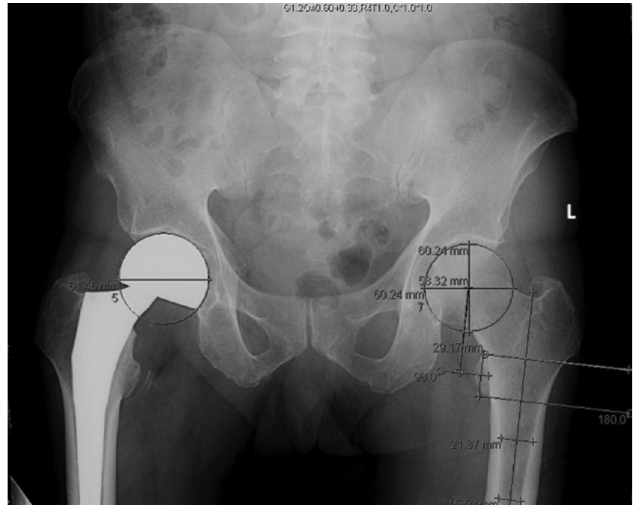
Measurement of vertical femoral offset. Step 6: Using the measurement tools to obtain the centre of lesser trochanter and Fig. 3: measuring the vertical femoral offset.